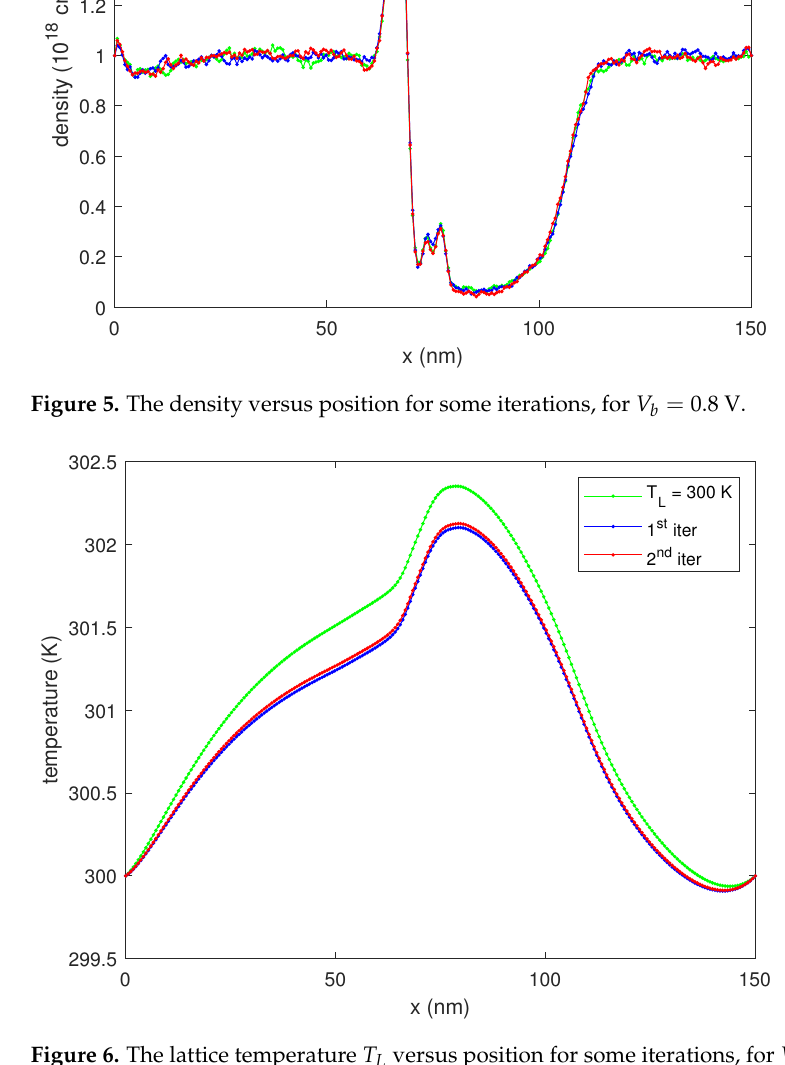
Figure 6. The lattice temperature T L versus position for some iterations, for V b = 0.8